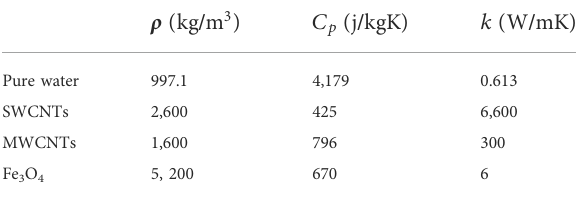
TABLE 1 Experimental values of water, CNTs ,and Fe 3 O 4 nanoparticles (Gul et al.,